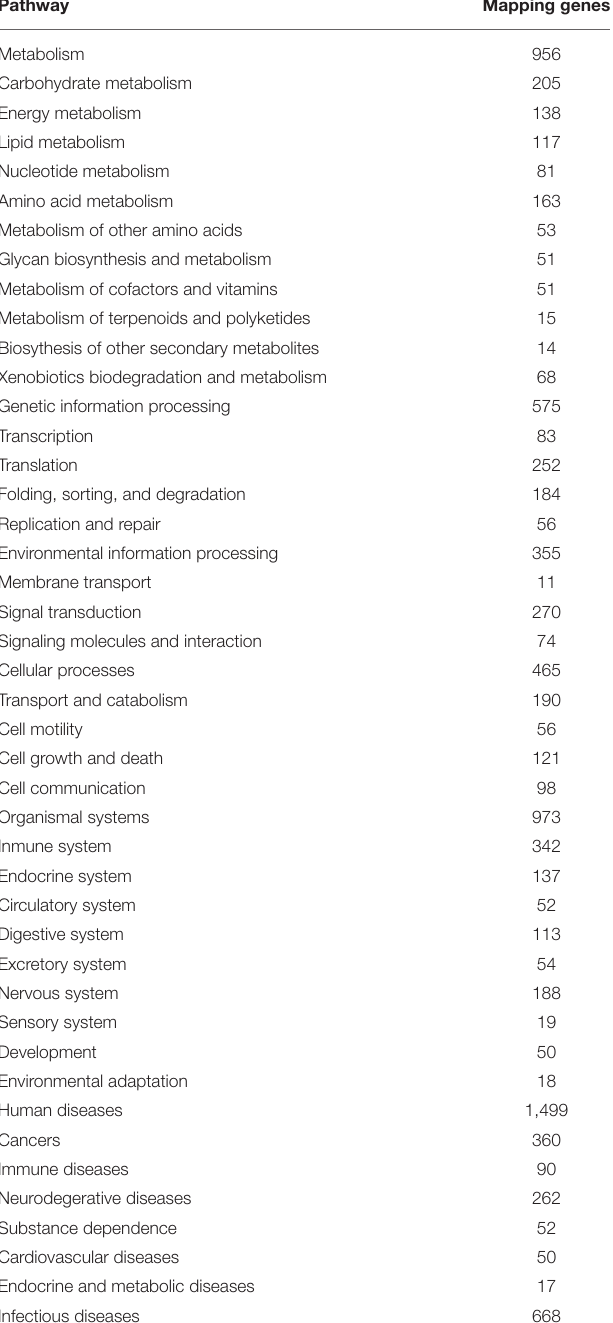
TABLE 4 | Biochemical pathway mapping (KEGG) for southern hake